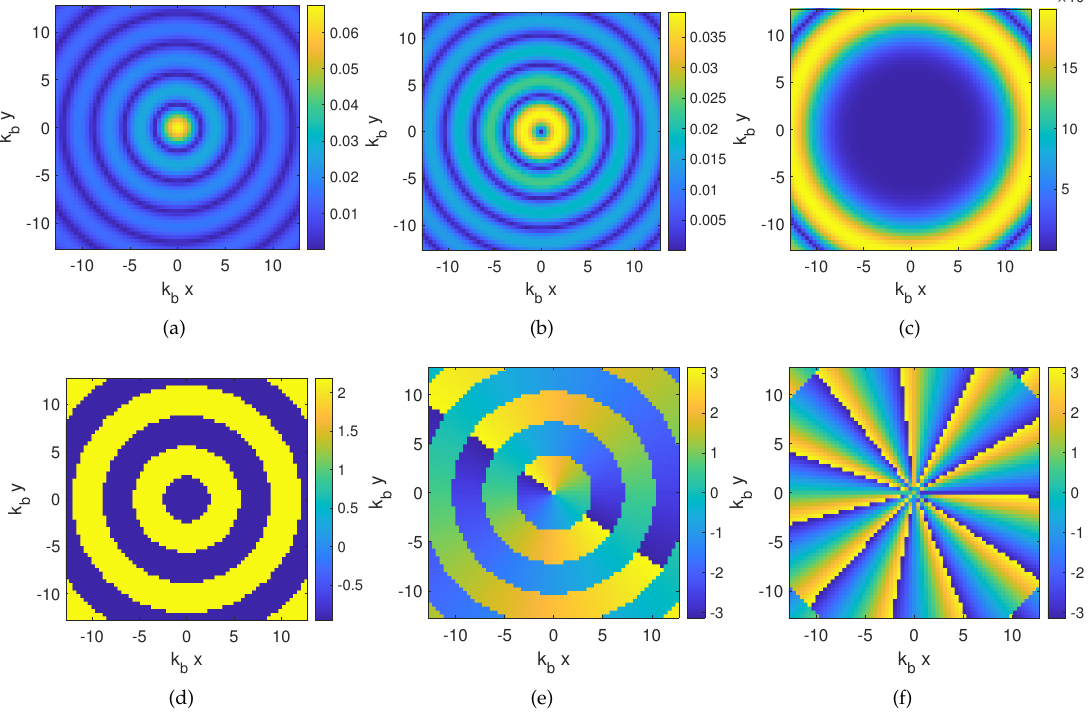
Figure 2. Amplitude (not normalized) and phase distribution of the OAM incident fields used to probe the imaging domain with a circular array of V = 36 filamentary currents. ( a ),( d ) (cid:96) = 0; ( b ),( e ) (cid:96) = 1; ( c ),( f ) (cid:96) =